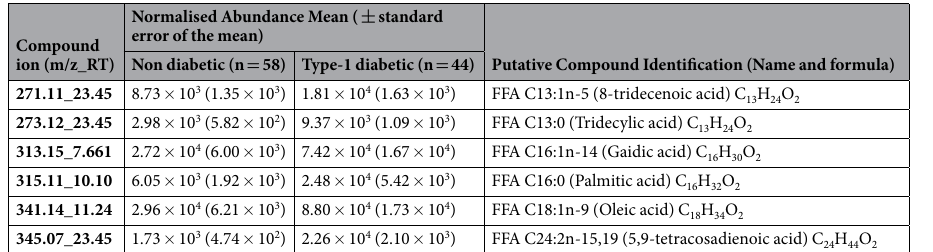
Putative Compound Identification (Name and formula)Non diabetic (n = 58) Type-1 diabetic (n = 44)